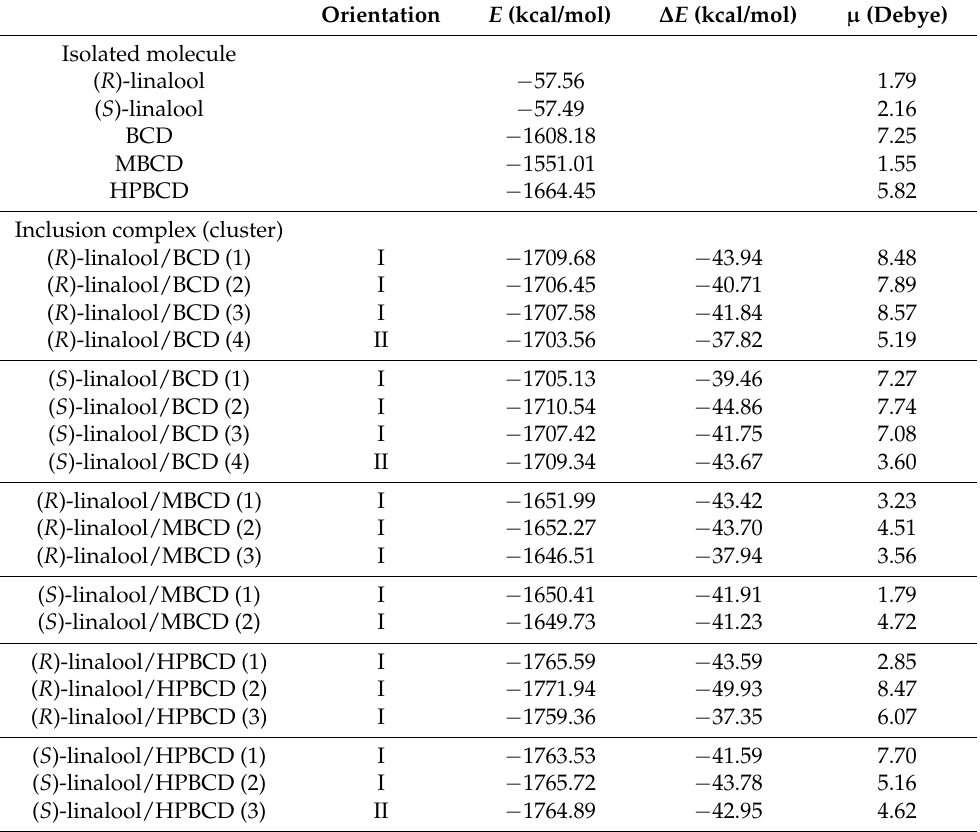
Table 2. Heat of formation energy ( E ), complexation energy ( ∆ E ), and the dipole moment ( µ ) of the minimized linalool/BCD inclusion complexes structures from PM7